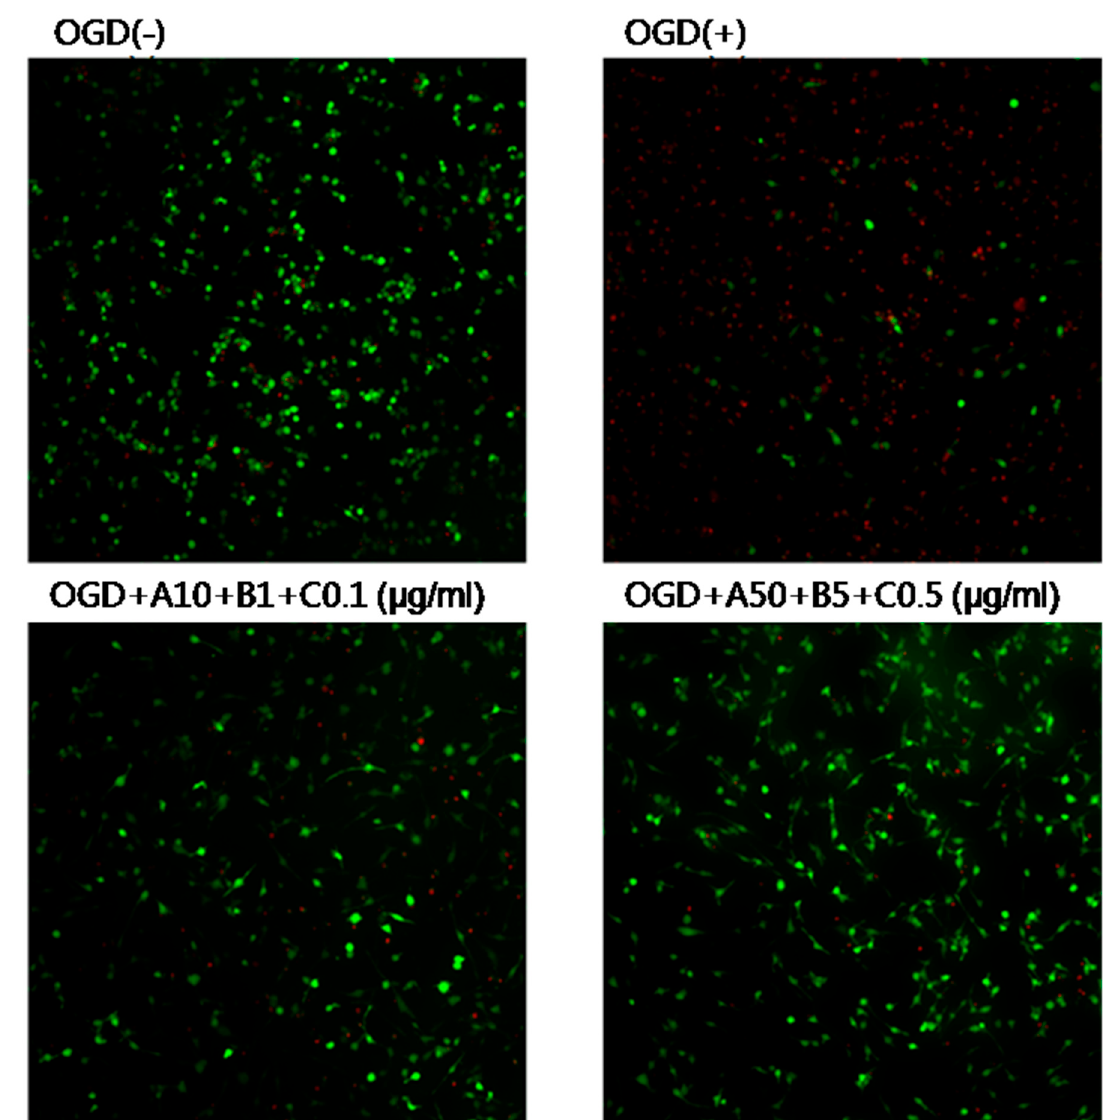
Figure 7. Effects of Sample A + B + C on OGD-induced cell death in SH-SY5Y cells. Green and red dots indicate live and dead cells, respectively. OGD exposure resulted in cell death, which was significantly reduced by treatment with the experimental drugs. OGD, oxygen–glucose deprivation; A, Chunghyuldan; B, ethanol extract of Radix Salviae Miltiorrhizae and Radix Notoginseng; C, Borneolum Syntheticum.